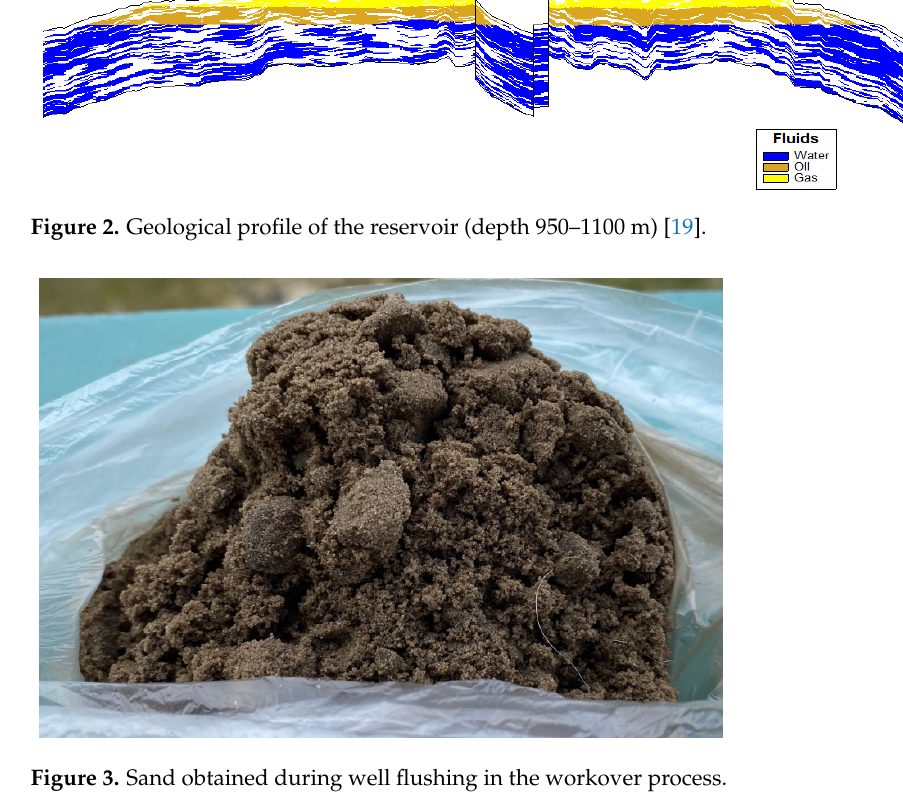
Figure 1. Left part—Snapshot of core rock ( a )—weakly consolidated highly permeable sandstone of “channel” facies, ( b )—interbedding of heterogeneous argillaceous sandstone of the “floodland” facies), Right part represents sedimentary environment [18].